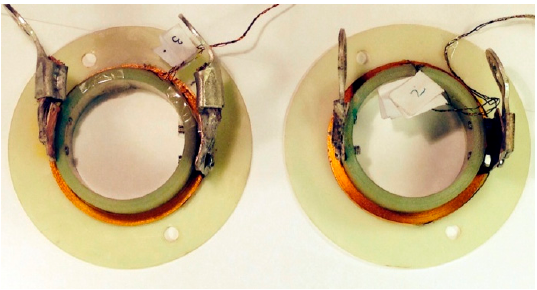
Figure 1. The 20-turn coils: ( left ) SuNAM coil; ( right ) SuperPower coil.